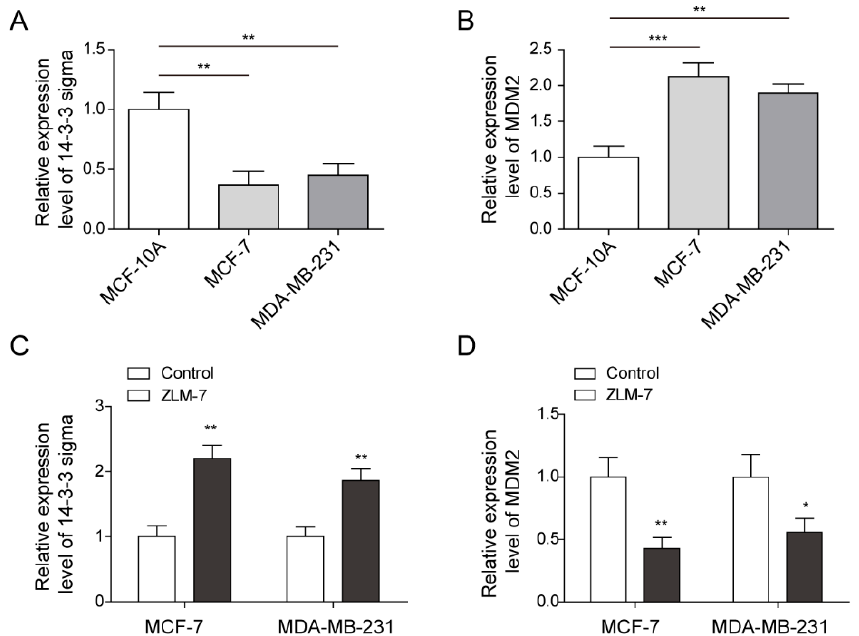
Figure 1. ZLM-7 upregulated 14-3-3 sigma expression but downregulated MDM2 expression in breast cancer cells. ( A , B ). Relative gene expressions of 14-3-3 sigma and MDM2 in MCF-10A, MCF-7 and MDA-MB-231 cells measured by qPCR. ( C , D ). Relative gene expression of 14-3-3 sigma and MDM2 with or without ZLM-7 treatment. Gene expressions were measured by qPCR. * p < 0.05, ** p < 0.01, *** p < 0.001.